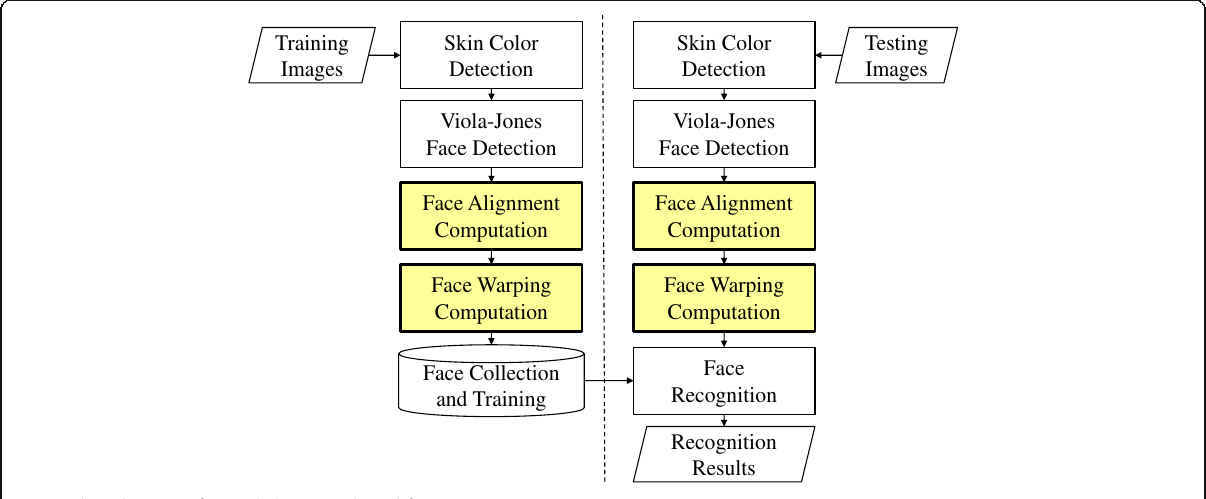
Fig. 5 Flow diagram of typical alignment-based face recognition